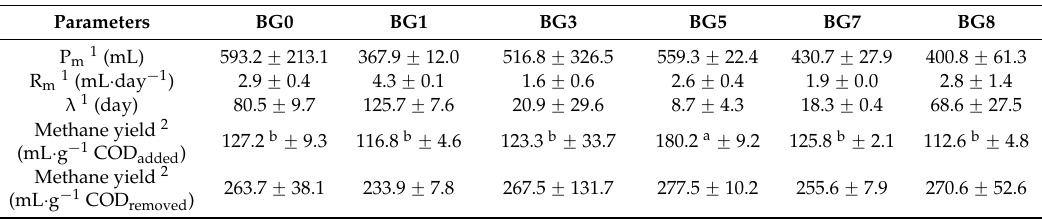
Table 6. Methane yields and modified Gompertz model parameters of methane production from each treatment.